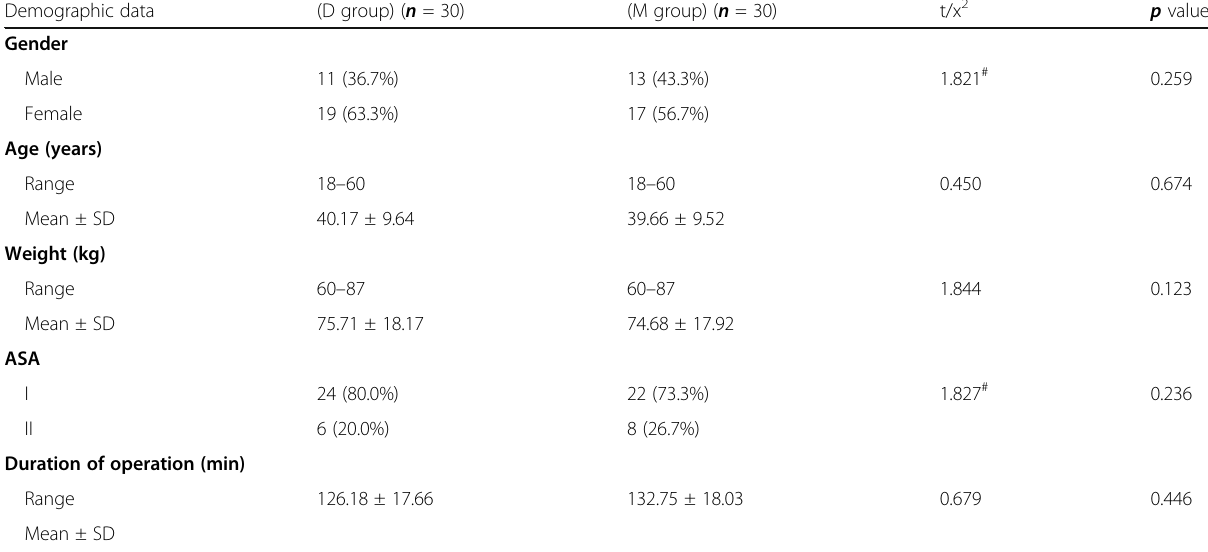
Table 3 Comparison between both groups according to demographic data Demographic